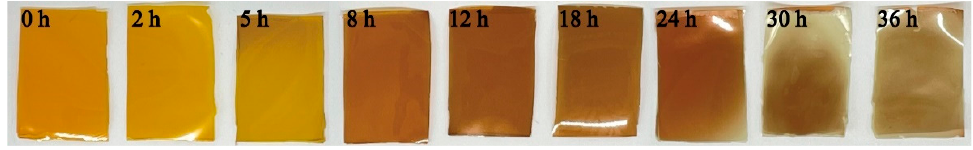
Figure 6. Photographs of C-0.22Ag film after reaction with 2 ppm H 2 S.